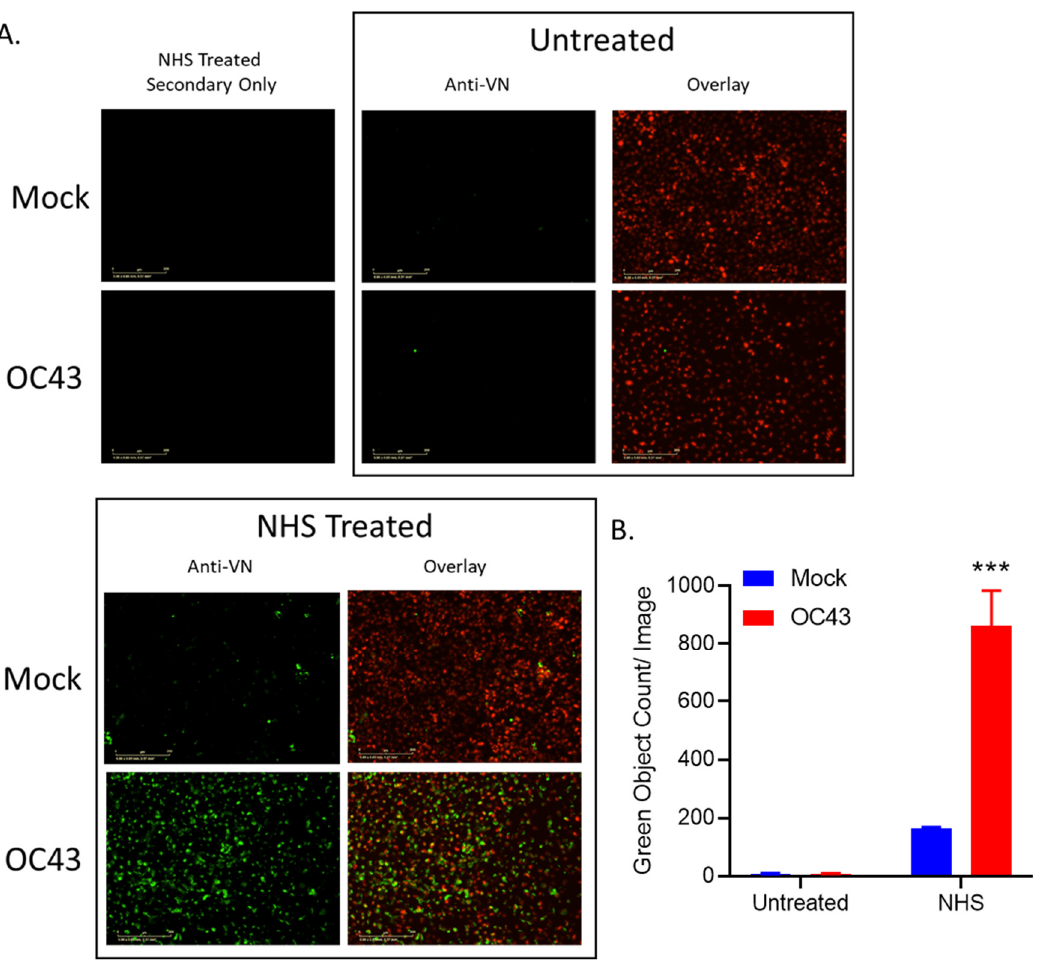
Figure 7. VN from serum was recruited to the surface of OC43 infected lung cells. ( A , B ) Uninfected (mock) or OC43 infected H1299-NLR cells were either untreated or treated with NHS for 2 h. Cells were washed, fixed, and stained for surface VN as detected by immunofluorescence. Cells were then imaged on the IncuCyte under 20× objective ( A ) and VN positive stained cell counts were determined per image ( B ). Red corresponds to the cell nuclei expressing red fluorescent protein and green corresponds to VN staining. Values are the mean of three replicates and error bars representing standard deviation, with *** indicating p -value of <0.001 comparing NHS treated uninfected (mock) cells versus NHS treated OC43 infected samples. Mock denotes uninfected control